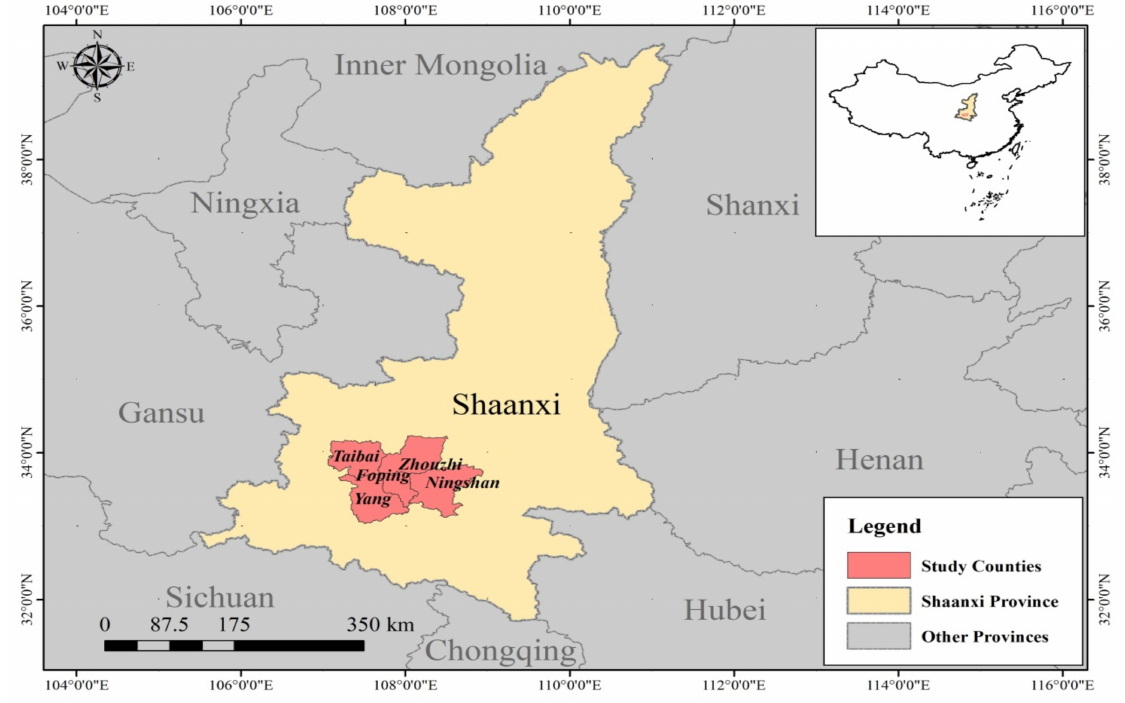
Figure 2. Distribution of the study